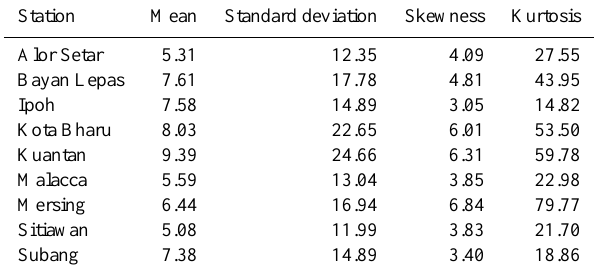
Table 2c. Statistics for the daily rainfall series after break.